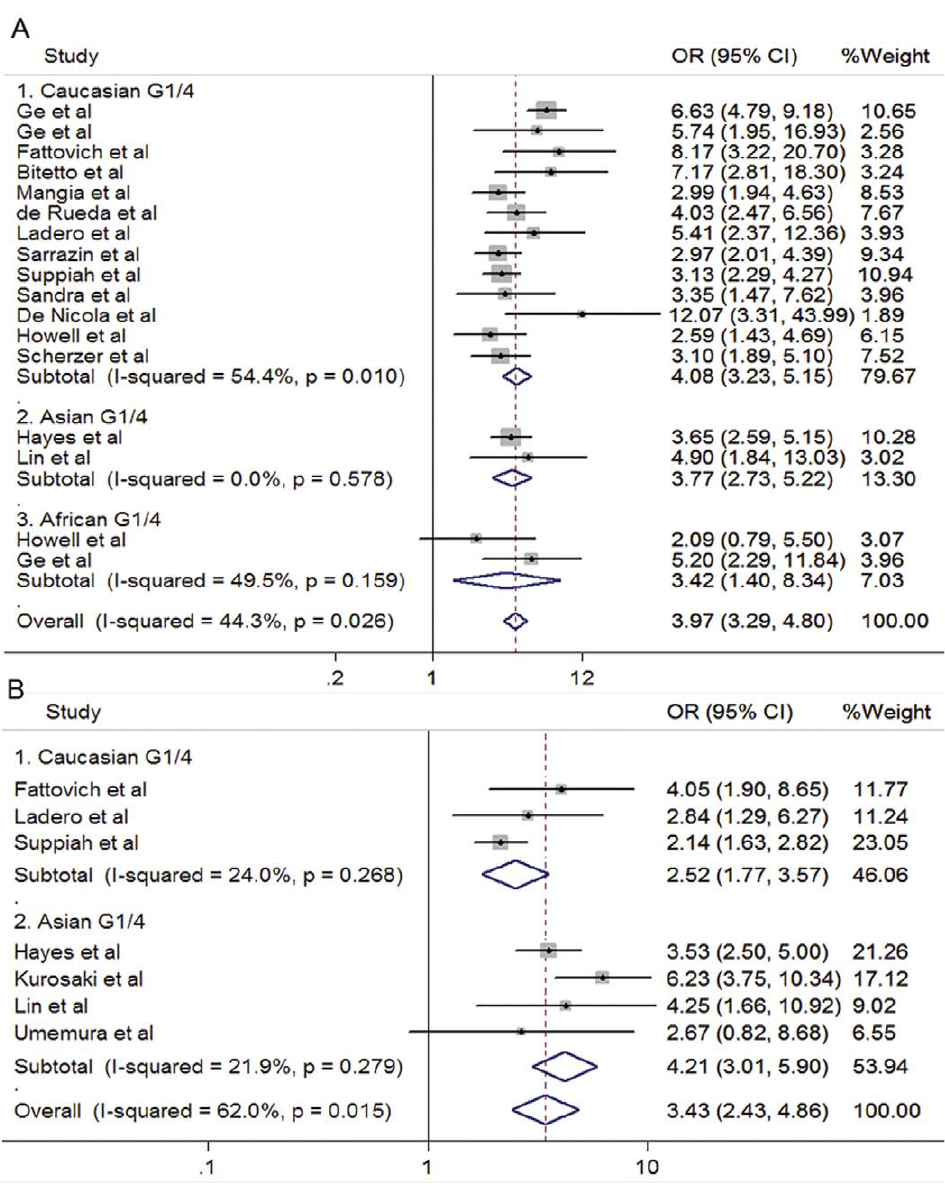
Figure 2. Forrest plots for association between polymorphisms and response to PegIFN/RBV in treatment-naı¨ve HCV G1/4 patients. A. rs12979860 (CC vs CT/TT). B. rs8099917 (TT vs